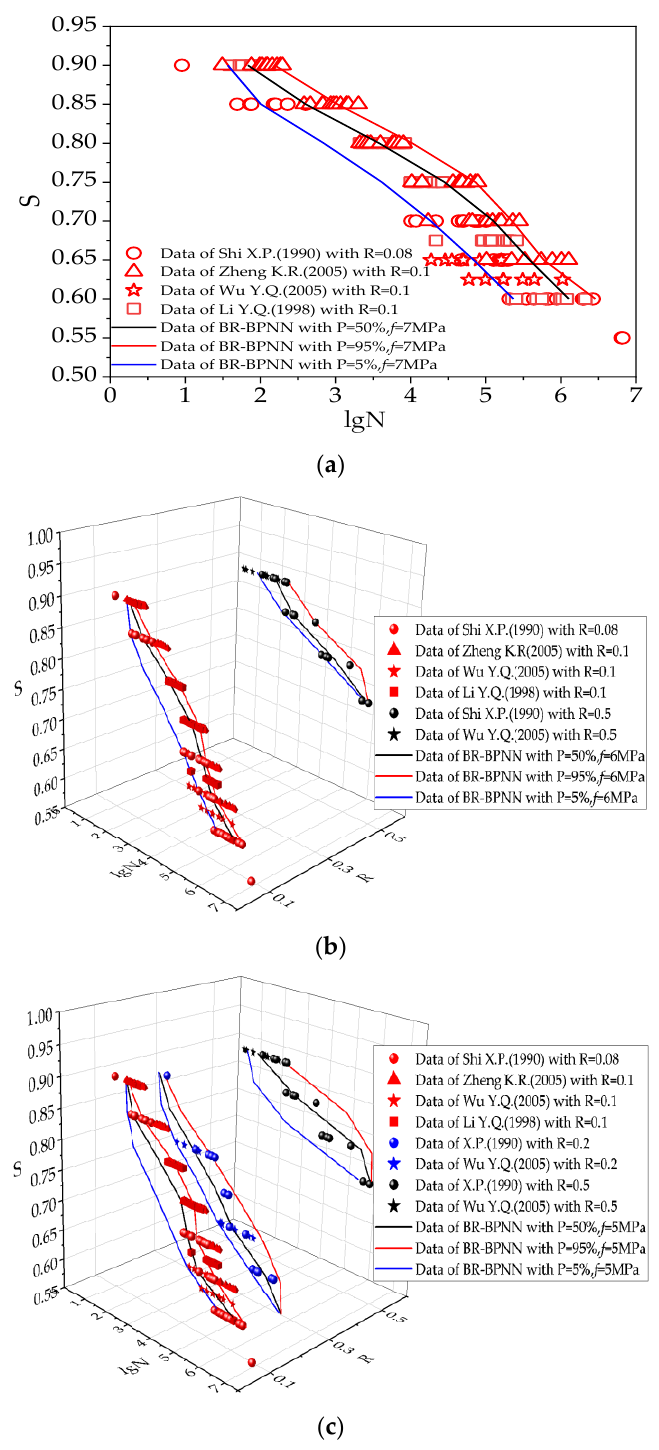
Figure 11. Probabilistic S-N curves predicted by BR-BPNN: ( a ) Probability analysis for f = 7 MPa; ( b ) Probability analysis for f = 6 MPa; ( c ) Probability analysis for f = 5 MPa.